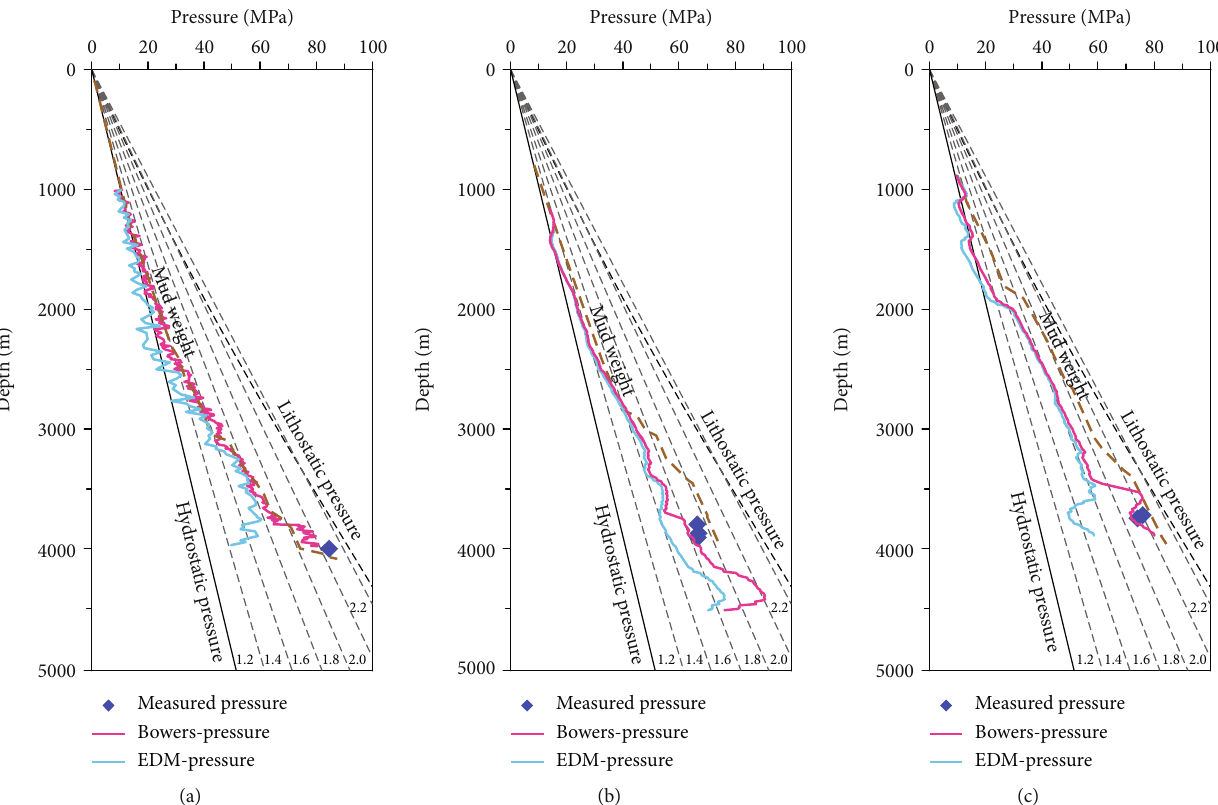
Figure 15: Pore pressure prediction of three wells in the Ledong Slope in Yinggehai Basin. Bowers-Pressure means the pore pressure is predicted by the Bowers method; EDM-Pressure means the pore pressure is predicted by equivalent depth